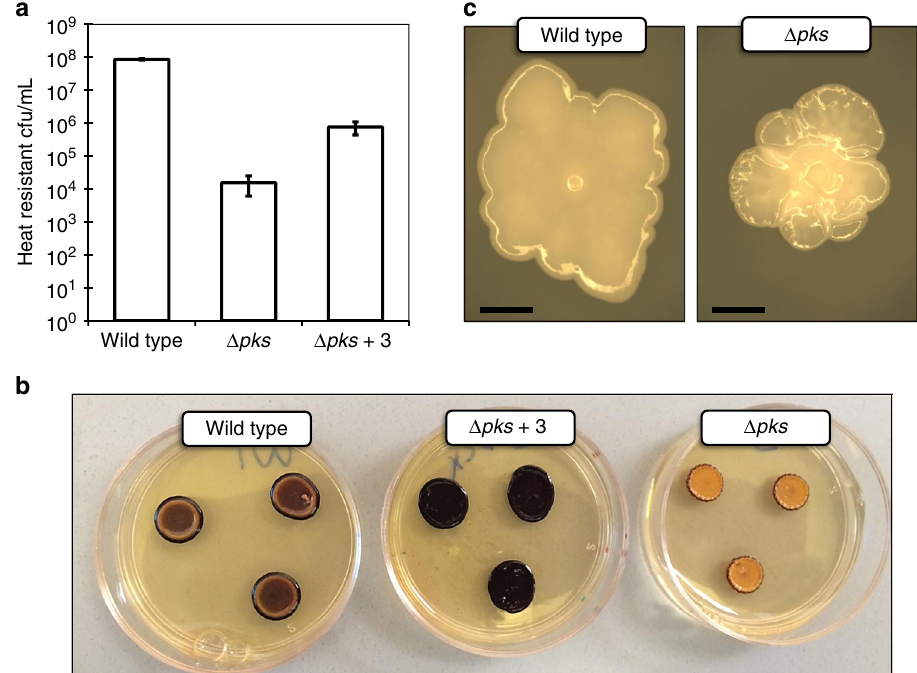
Fig. 4 Phenotype comparison of wild-type C. acetobutylicum and Δ pks . a Sporulation assay results for liquid cultures of wild type, Δ pks , and Δ pks supplemented with clostrienose ( 3 ). Values represent the number of heat-resistant colony forming units per mL following incubation in liquid CBM-S medium for 5 days. Error bars represent the standard deviation of biological triplicate cultures. Experiments were repeated at least three times independently. b Granulose accumulation assay results for wild type, Δ pks , and Δ pks supplemented with clostrienose ( 3 ). Patches containing high levels of granulose are expected to stain dark brown/ purple. c Dissecting microscope images of individual wild-type and Δ pks colonies. Black scale bar shows 1mm in